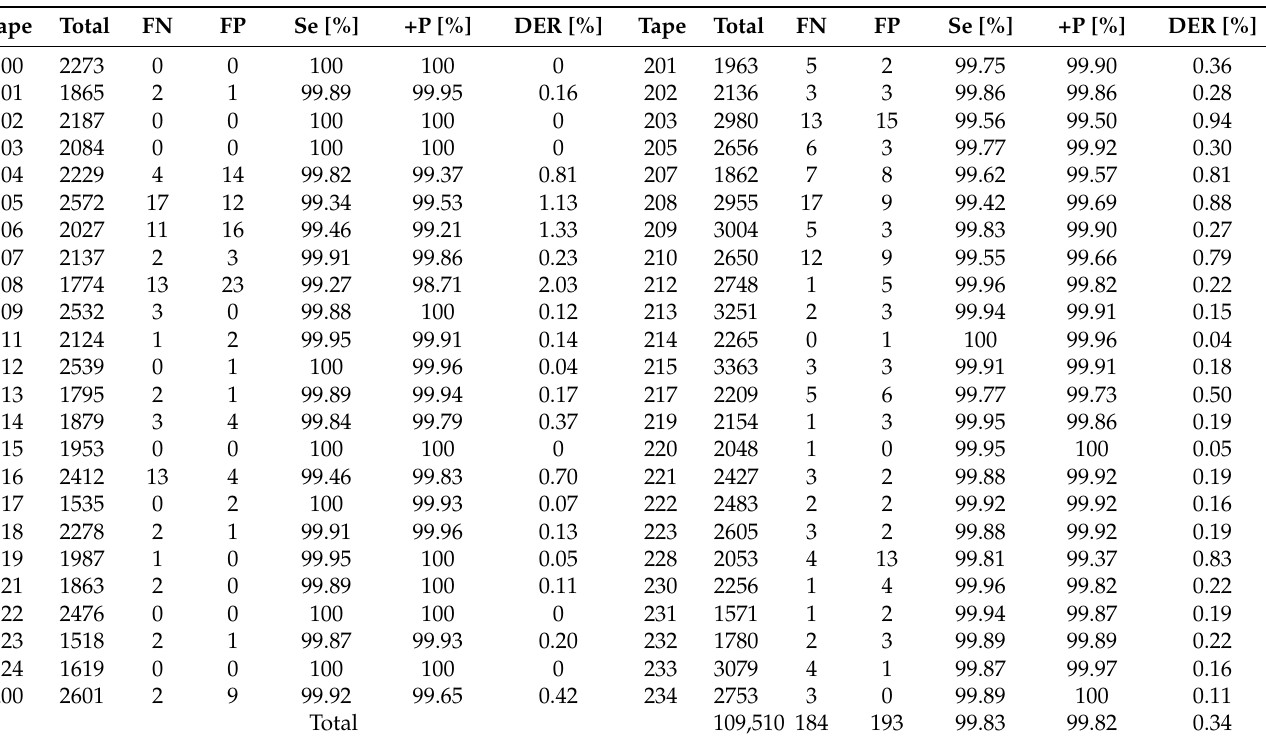
Table 2. R-peak detection performance of the proposed method for the MIT-DB.